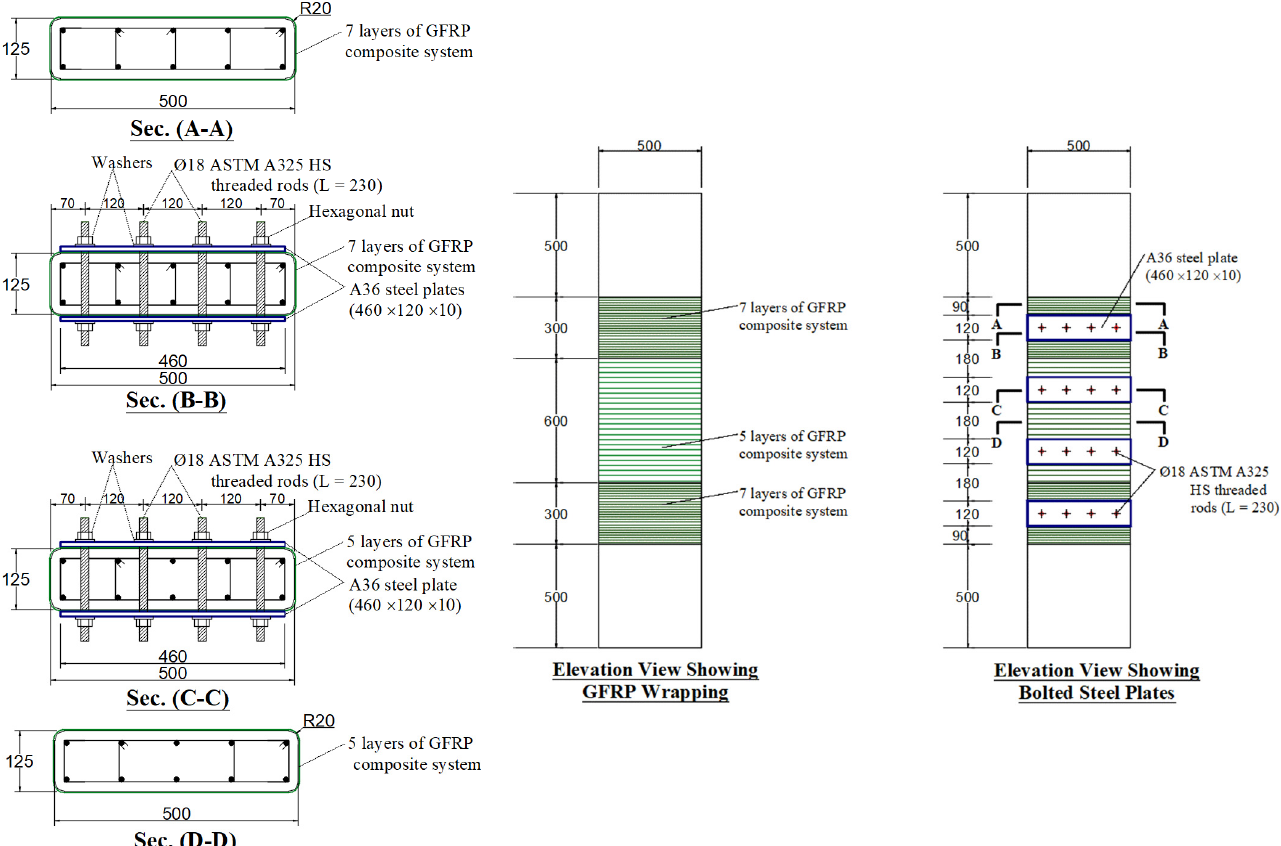
Figure 3. Details of strengthened column S2 (units of dimensions = mm).